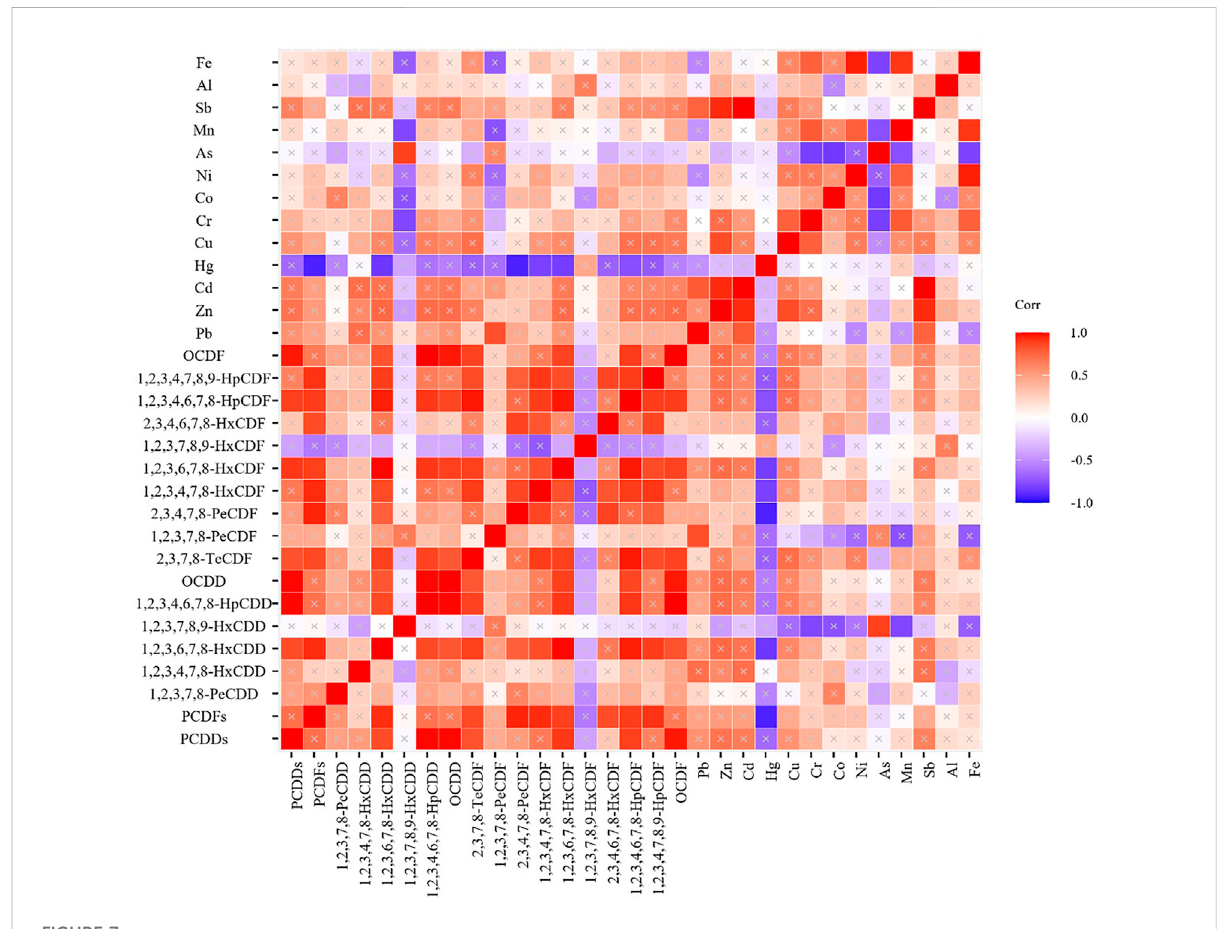
FIGURE 7 Correlation analysis of metals and dioxin